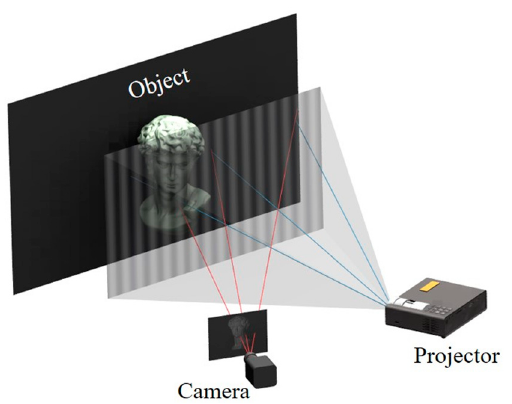
Figure 1. Classical fringe projection profilometry (FPP) system.